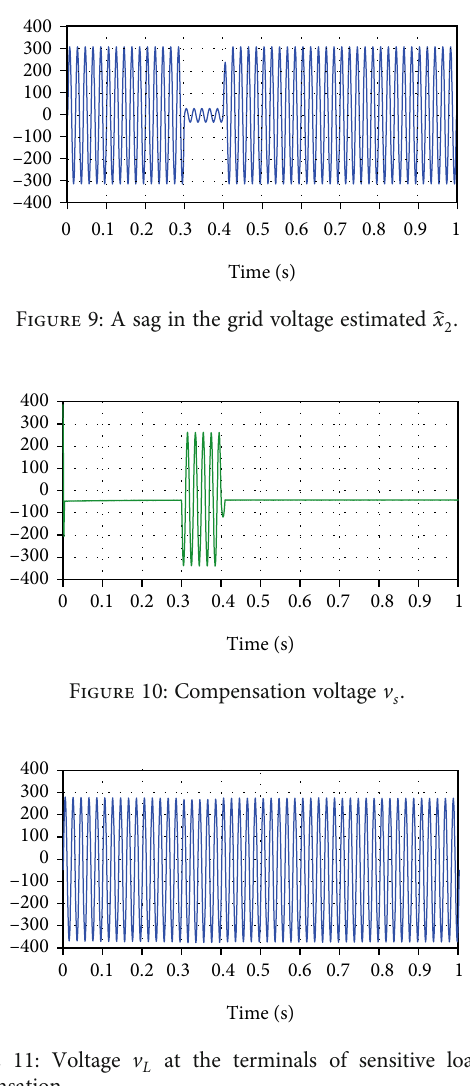
at the terminals of sensitive load after L